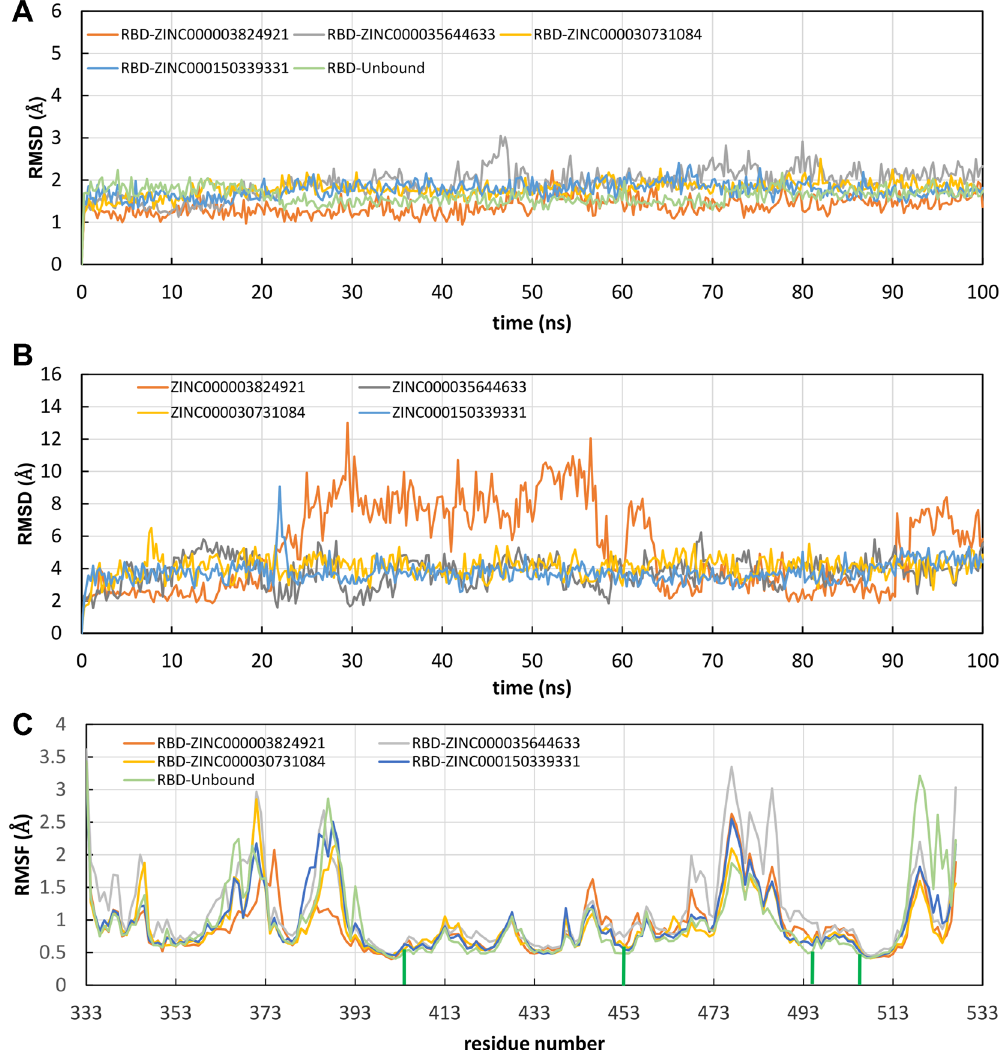
Figure 6. Evolution of structural properties over time. ( A ) Stability of the predicted complexes represented as the time evolution of the Cα-RMSD. ( B ) Variation of ligand RMSD with time. ( C ) Residue-based Cα-RMSF calculated over the entire trajectory. The green bars indicate the main contacts involved in molecular